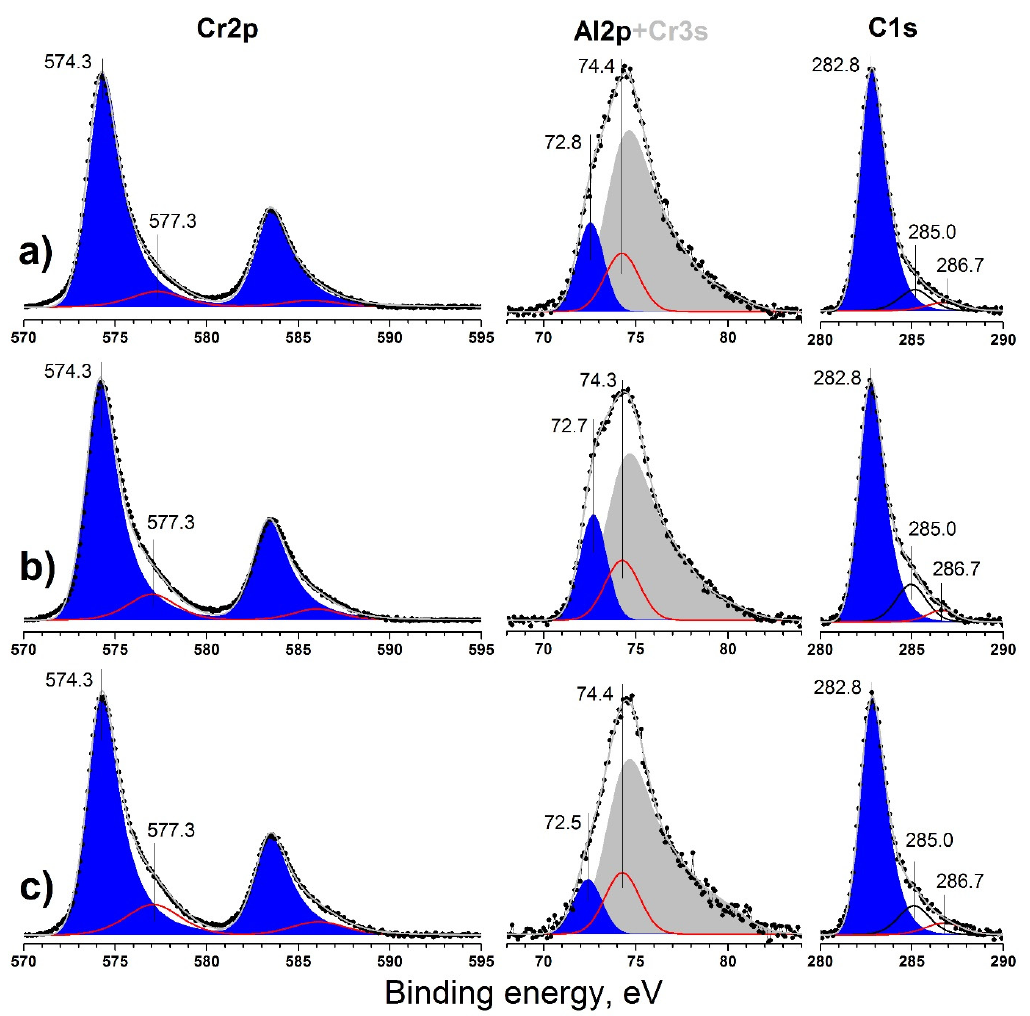
Figure 4. Cr2p, Al2p, and C1s XP-spectra obtained for Cr-Al-C films at ( a ) 120 V; ( b ) 90 V; and ( c ) 60 V after Ar + ion etching for 120 min.